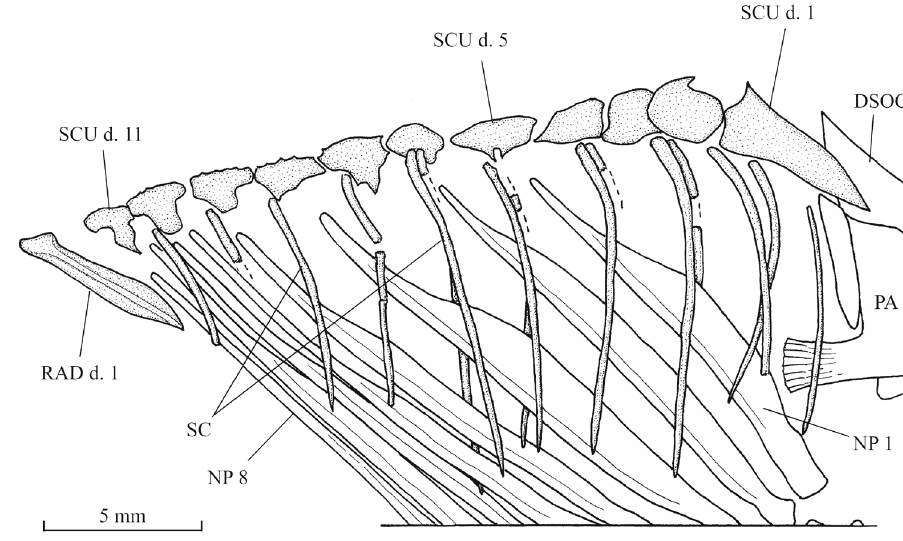
Fig. 10. Libanopycnodus wenzi gen. et sp. nov., holotype, dorsal ridge scutes (CLC